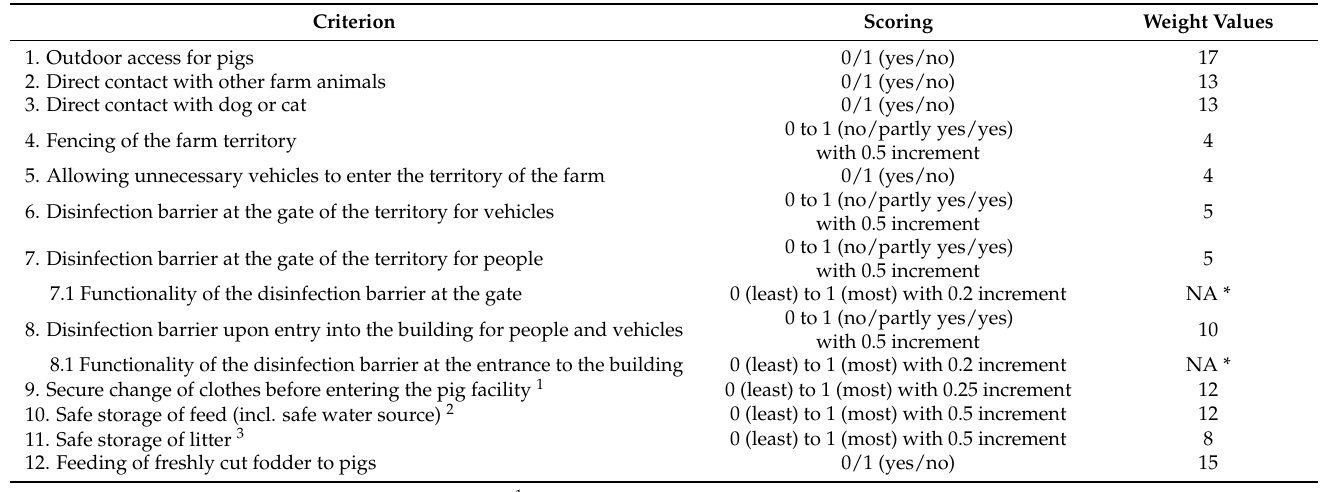
Table 1. The evaluation criteria, the scoring system and weights values used in assessing the external biosecurity of pig farms in